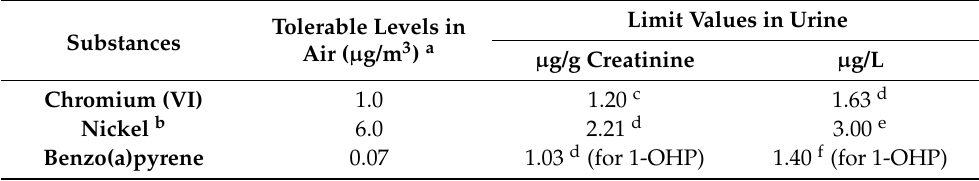
Table 1. Tolerable risk levels and limit values used for risk assessment calculations. Tolerable Levels Substances